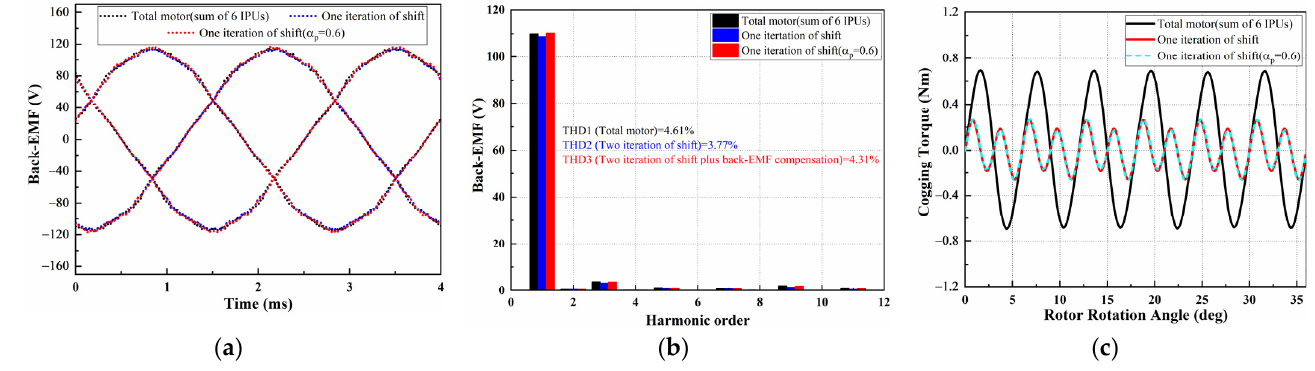
Figure 10. Back-EMF compensation of the 10P12S machine: ( a ) waveforms, ( b ) FFT, and ( c ) cogging torque after back-EMF compensation.